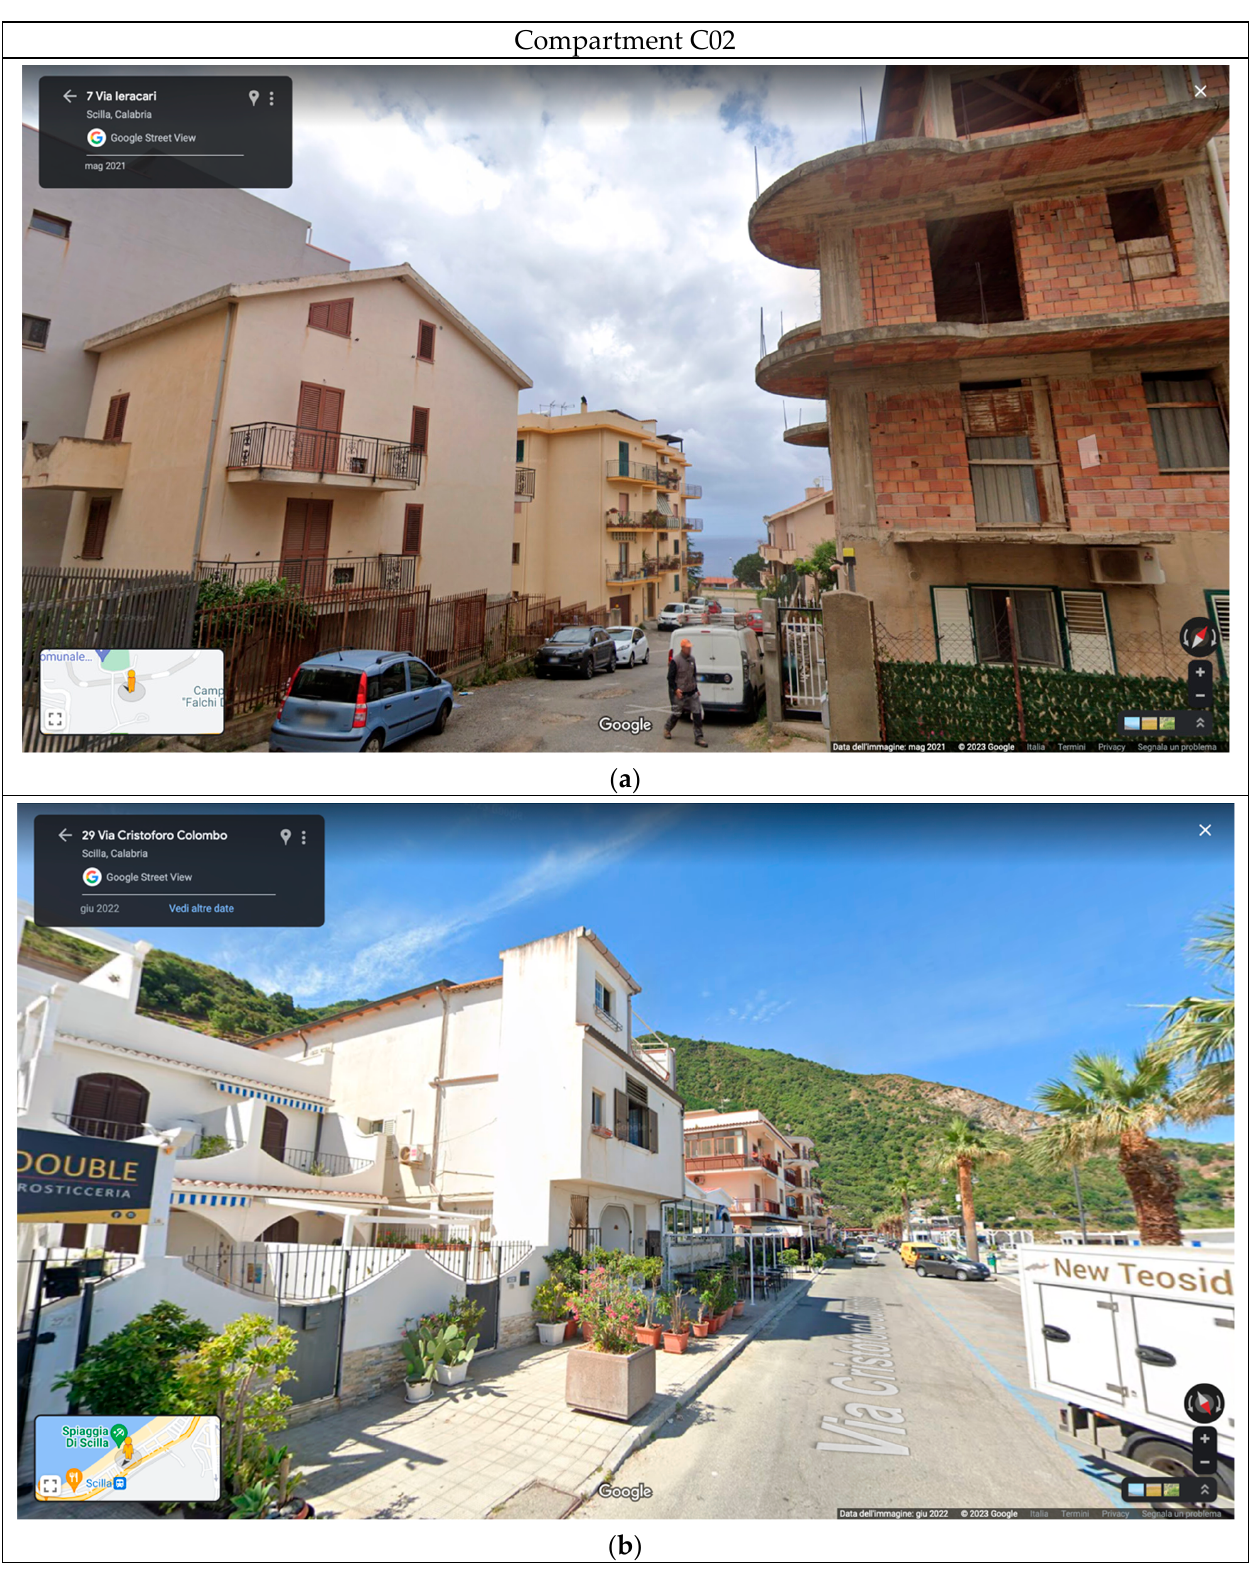
Figure 6. Digital survey of the buildings of the Compartment C02 of Scilla via Google Maps. ( a ) https://goo.gl/maps/veM4mLysdkrhefFR9 (accessed on 19 January 2023), ( b ) https://goo.gl/maps/Vy6QZzRQ13nAPRpp7 (accessed on 19 January 2023).